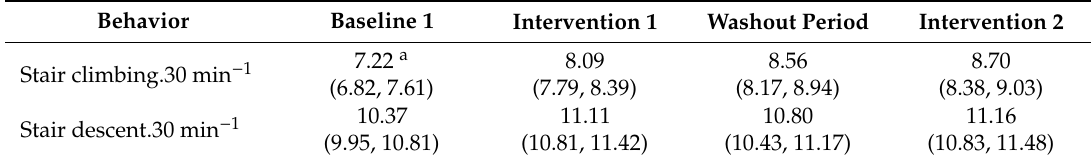
Table 4. Mean stair use (95% CIs) every 30 min for the di ff erent intervention stages in